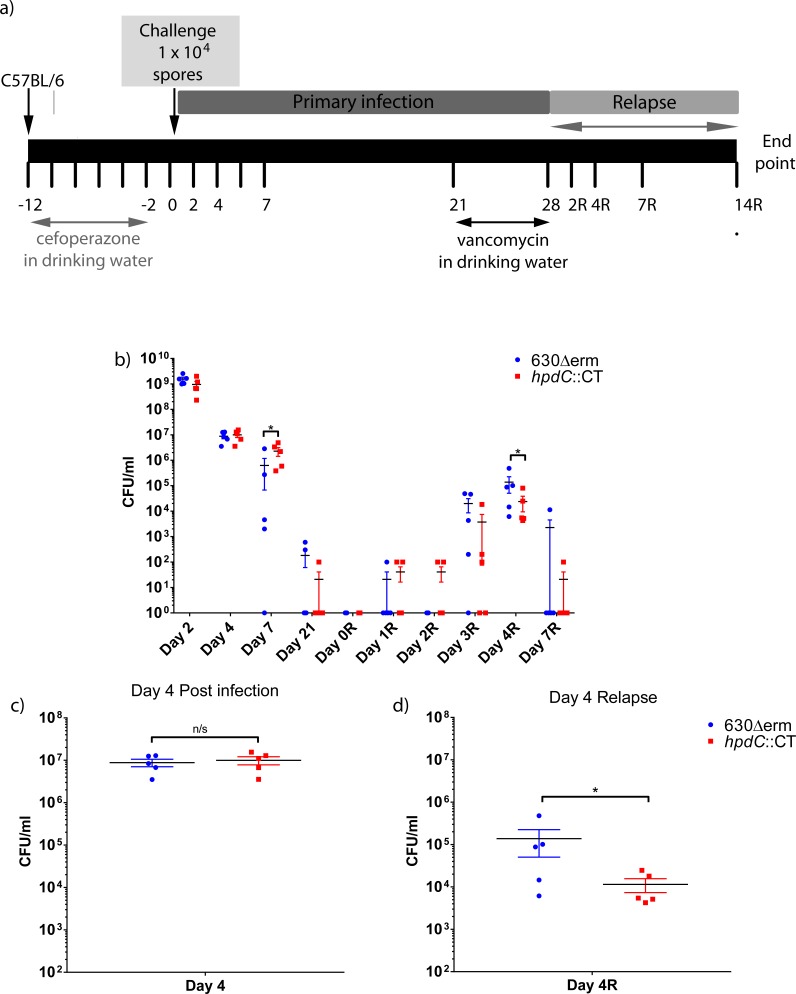
Infection of mice with 630Δerm and hpdC::CT.a) A schematic of the C. difficile relapse infection in C57BL/6 mice. b) CFU counts enumerated from the faeces of individually caged animals (n = 5) infected with either wild-type C. difficile strain (630Δerm) or the corresponding p-cresol null mutant (hpdC::CT) over the duration of the primary infection (days 1–21) and relapse (days 1R-7R). c) CFU enumerated from the faeces day 4 post-infection and d) day 4 relapse. Mann Whitney U test was used to calculate significant differences between infection with wild-type C. difficile and the hpdC mutant marked *p<0.05. Graphs were produced in GraphPad Prism 6.0.